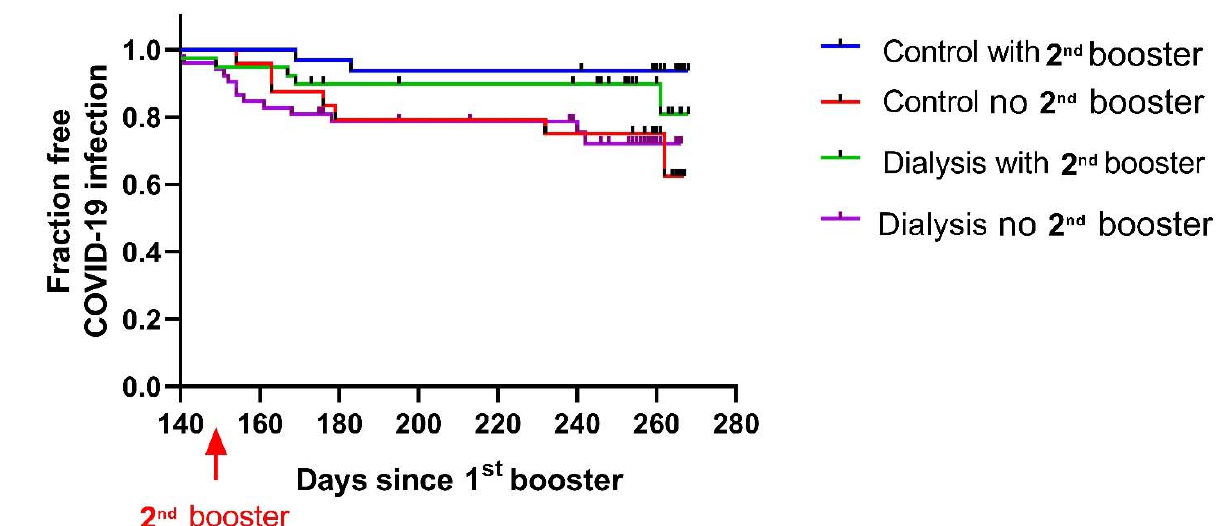
Figure 6. Fraction of SARS-CoV-2 infection after the second booster vaccination in dialysis patients (number at risk N = 90) and volunteers (number at risk N = 56) that were not infected until the time of starting second booster administration. Volunteers with (blue line) or without (red line) a second booster vaccination; dialysis patients with (green line) or without (purple line) a second booster.